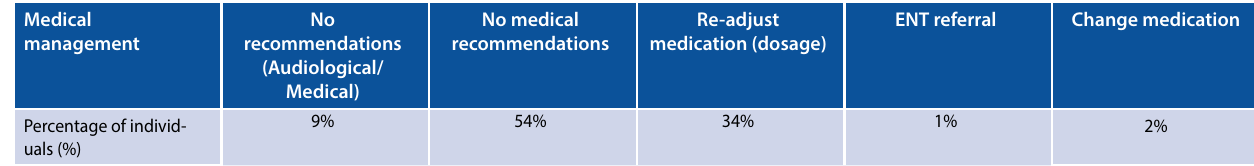
Table 5: Recommendations/suggested medical management protocols ( n = 124).